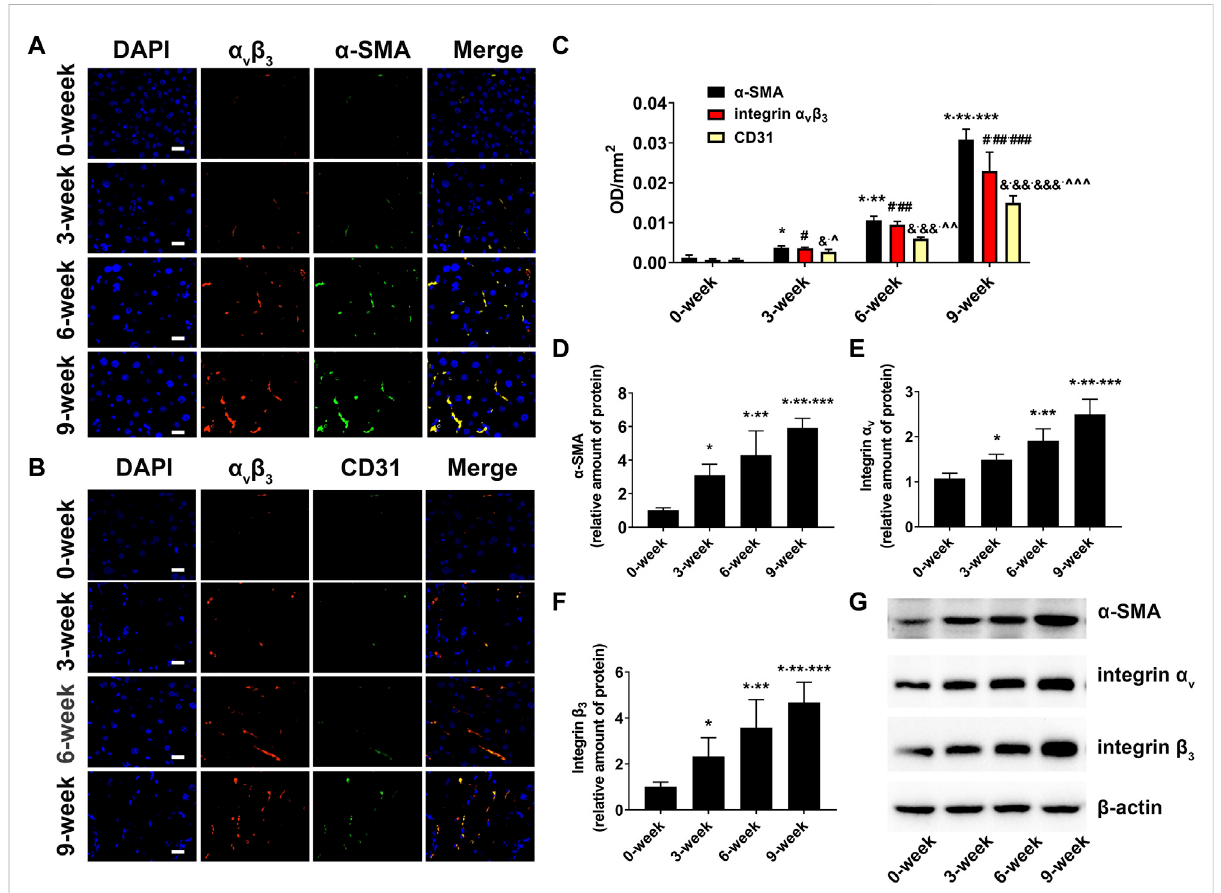
FIGURE 7 Biomarker expression in fi brotic livers (A) Immuno fl uorescent colocalisation of integrin α v β 3 and α -SMA in the liver fi brosis groups and control group (×400; Scale: 20 μ m). (B) Immuno fl uorescent colocalisation of integrin α v β 3 and CD31 in the liver fi brosis groups and control group (×400; Scale: 20 μ m). (C) Comparison of mean fl uorescence densities of integrin α v β 3 , α -SMA and CD31 in the liver fi brosis groups and control group (* p < 0.05 versus 0-week group; ** p < 0.05 versus 3-week group; *** p < 0.05 versus 6-week group; # p < 0.05 versus 0-week group; ## p < 0.05 versus 3-week group; ### p < 0.05 versus 6-week group; & p < 0.05 versus 0-week group; && p < 0.05 versus 3-week group; &&& p < 0.05versus6-weekgroup; ^ p < 0.05versus α -SMAinthe3-weekgroup; ^^ p < 0.05versus α -SMAinthe6-weekgroup); ^^^ p < 0.05versus α -SMAinthe9- week group). (D – G) Comparison of the protein level of α -SMA, α v and β 3 integrin subunits by western blot in the liver fi brosis groups and control groups ( * p < 0.05 versus 0-week group; ** p < 0.05 versus 3-week group; *** p < 0.05 versus 6-week